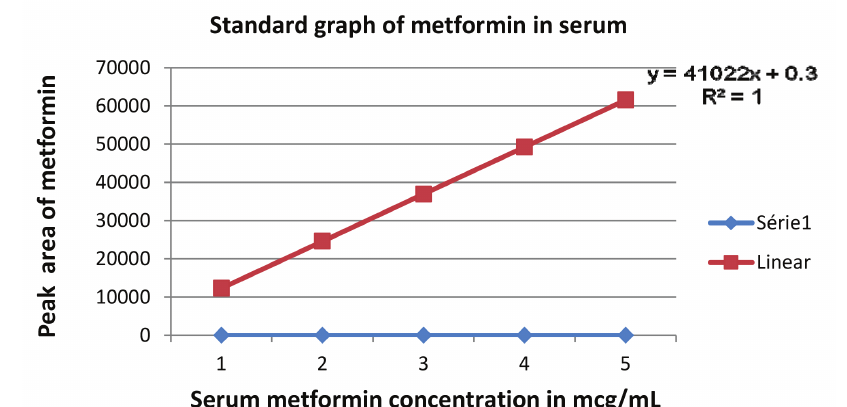
FIGURE 1 - Standard graph of metformin in